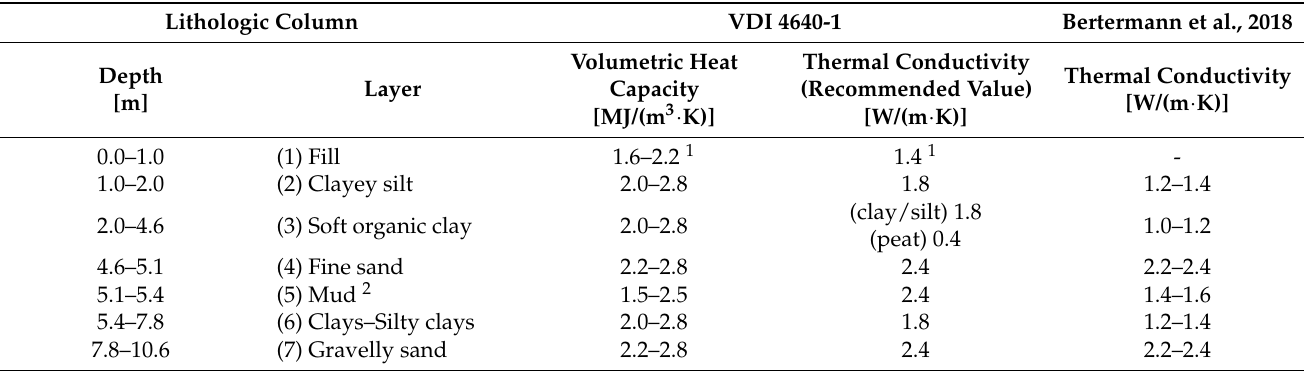
Table 2. The soil thermal properties according to VDI 4640-1 [2] and Bertermann et al., 2018 [46] assigned to the layering structure in the lithologic column under saturated conditions.